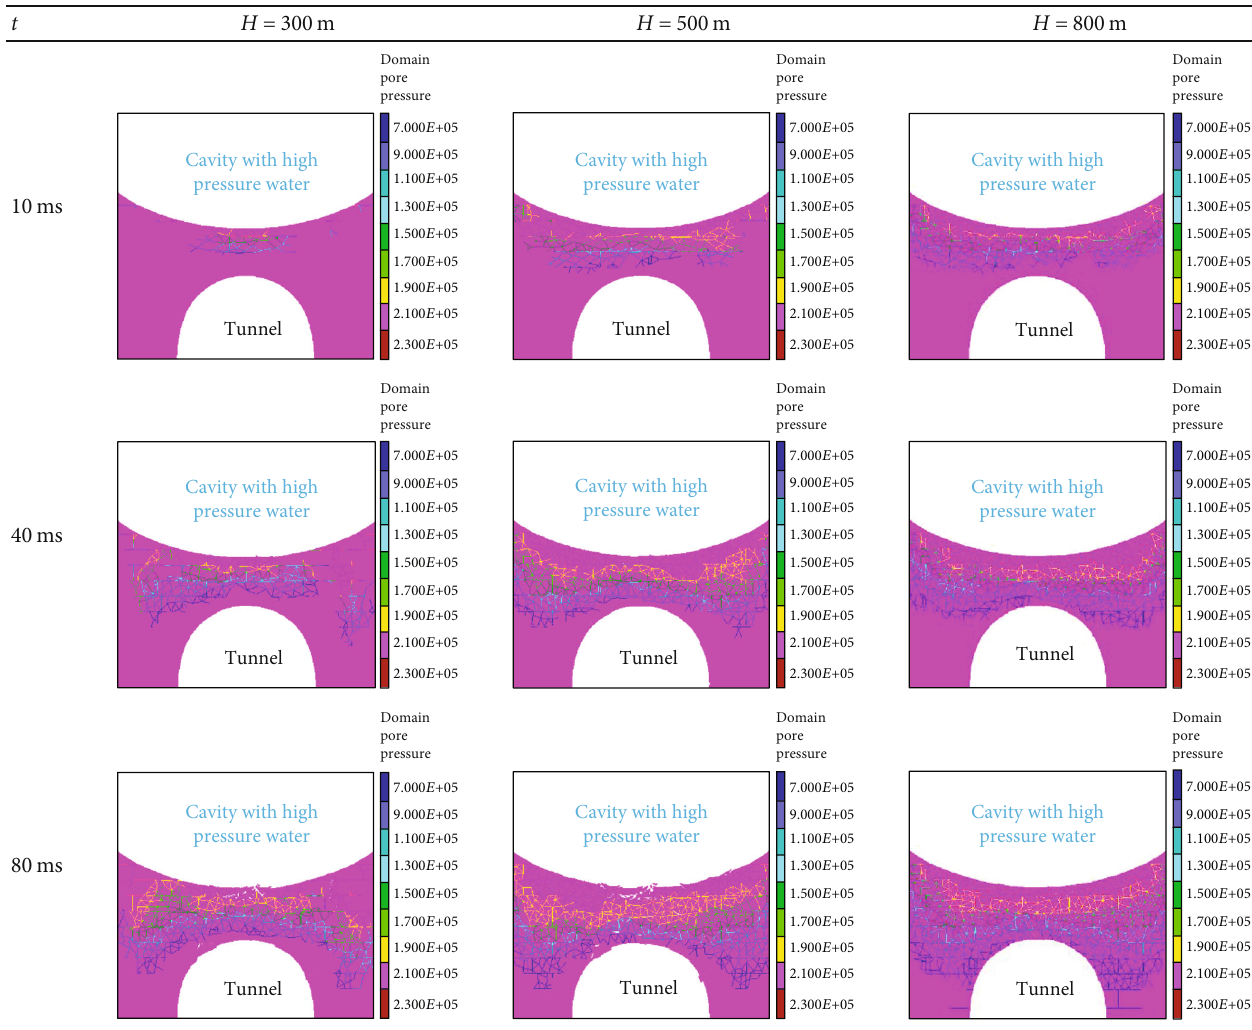
Table 6: The seepage pressure distribution in the water-resistant strata under the three cases of H = 300 , 500, and 800m at t = 10 , 40, and 80ms. t H = 300 m H = 500 m H = 800 m